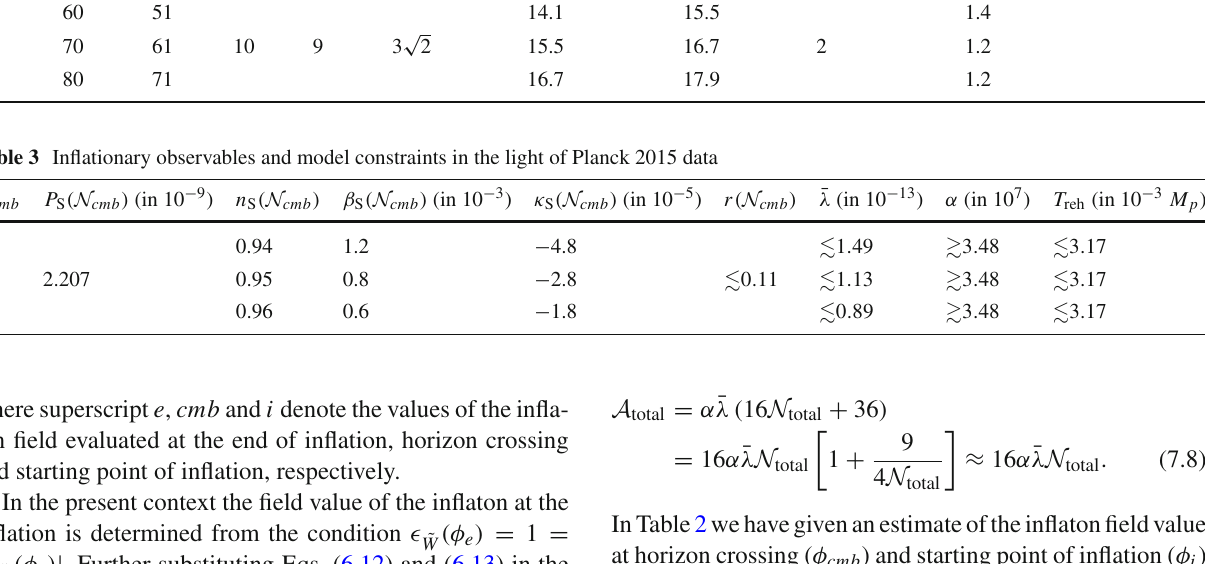
Table 2 Inflaton field value at the end, horizon crossing and starting point of inflation N cmb